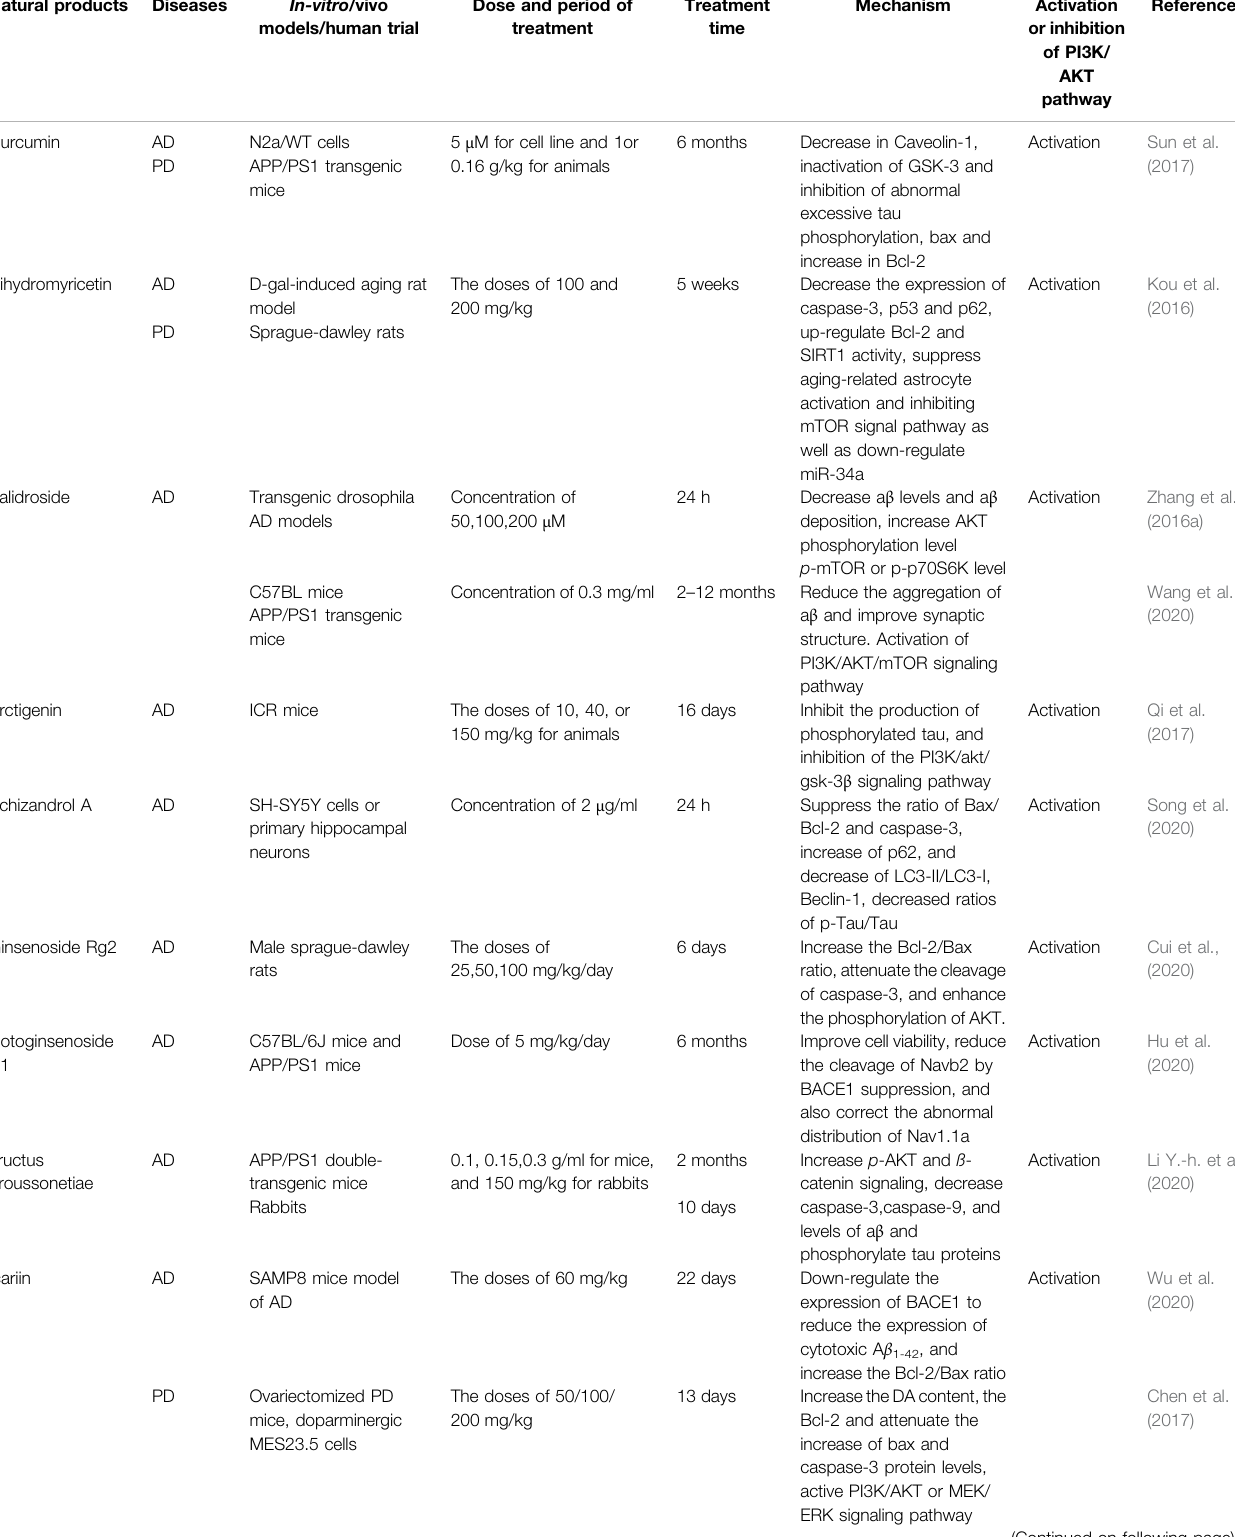
TABLE 1 | Summary of some natural products with AD and PD therapeutic